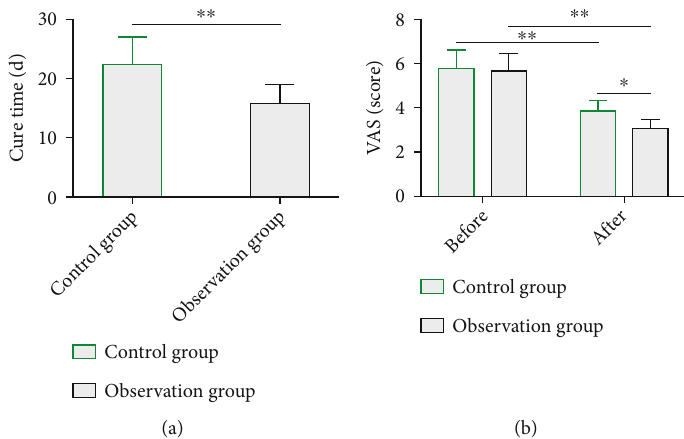
Figure 2: Healing time and pain degree of the two groups. (a) The observation group experienced statistically shorter healing time than the control group. (b) The observation group experienced statistically milder pain degree than the control group. Notes: ∗ P < 0 : 05 ; ∗∗ P < 0 : 01